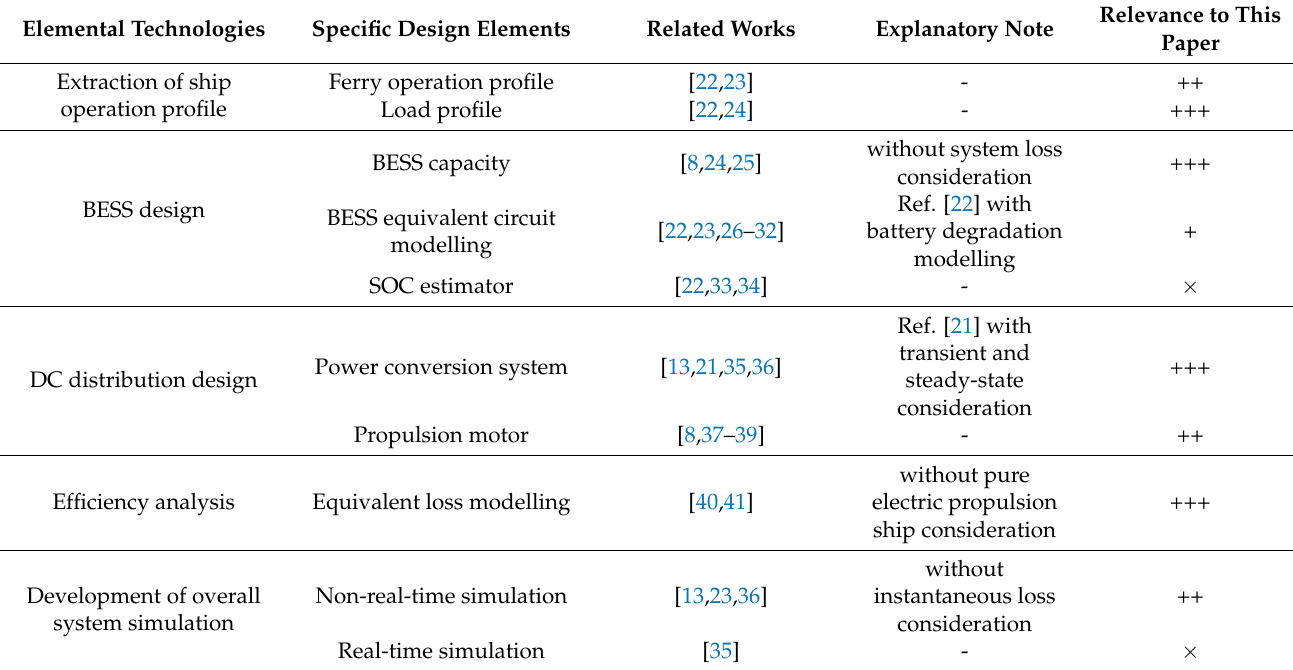
Table 1. Conventional studies on the design of an electric propulsion